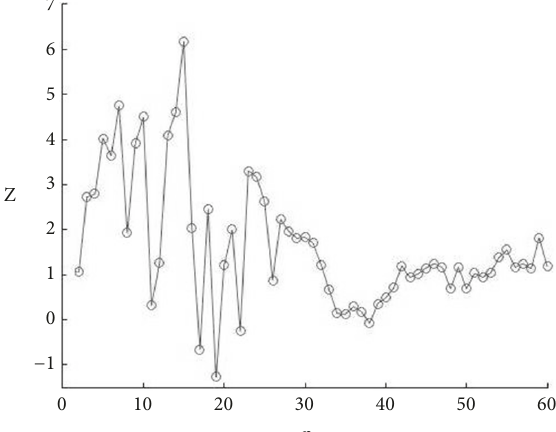
Figure 8: Graph 𝑍(𝑛) for the poem by George Gordon Byron “Remember thee.”